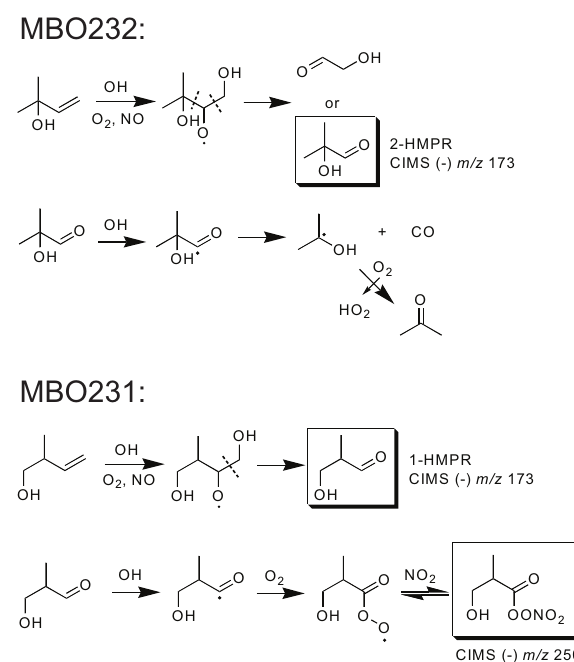
Fig. 15. Mechanism of MBO231 and MBO232 photooxidation un- der high-NO x conditions. The dashed lines indicate possible loca- tions of C-C bond scission under decomposition of alkoxy radicals. For MBO232, 2-HMPR formation is relatively small, as scission of the C-C bond with the 4-carbon is not favored. In addition, the acyl radical from H-abstraction of 2-HMPR rapidly decomposes to CO and acetone. As a result, PAN formation is unlikely. For MBO231, 1-HMPR formation is favored from the decomposition of the alkoxy radical. Furthermore, OH reaction of 1-HMPR leads to an acyl per- oxy radical, which reacts with NO 2 to form a C 4